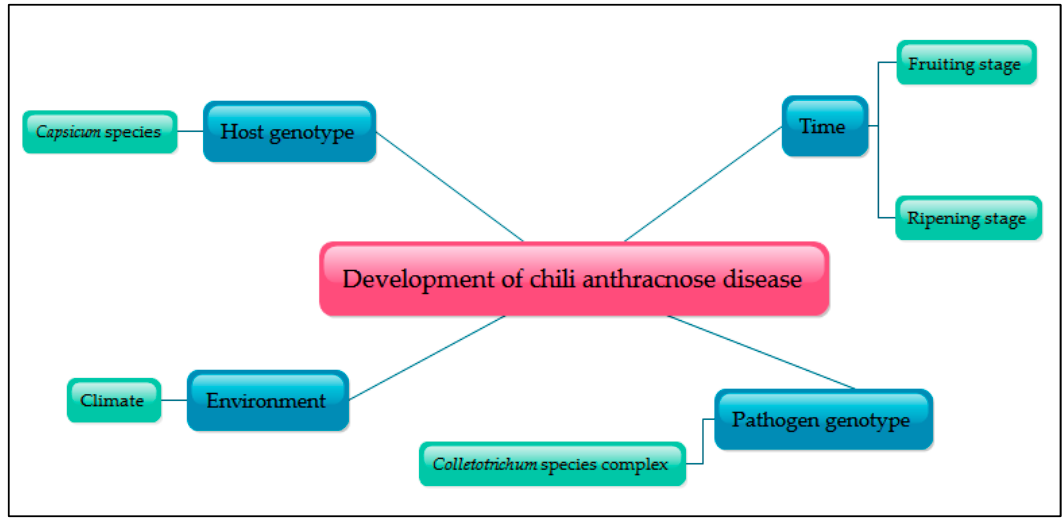
Figure 2. Four main factors in chili anthracnose disease development.